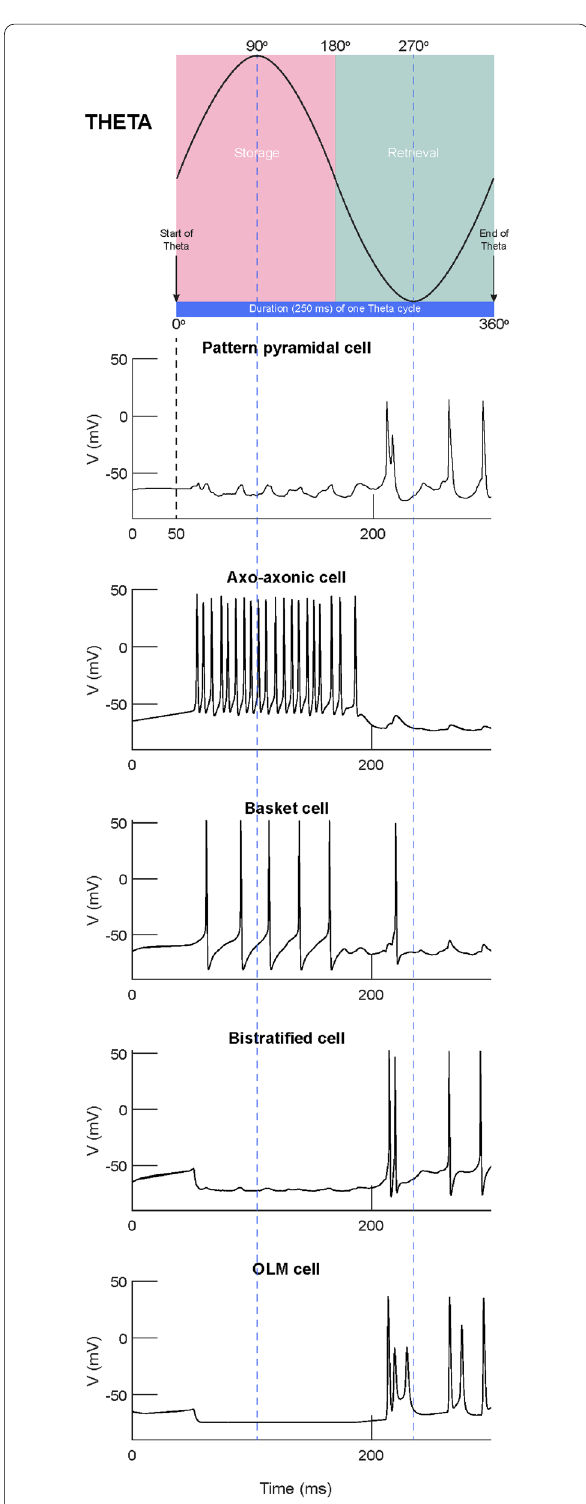
Fig. 3 Voltage traces of model cells with respect to a single theta